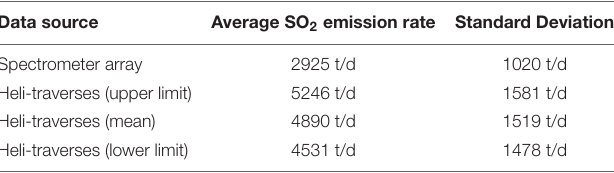
TABLE 2 | Summary of average emission rates obtained from the array and by DOAS helicopter traverses above the array and 3 km downwind of the array between 09:29 and 09:53 Hawai‘i Standard Time (HST) on 29 June 2017.